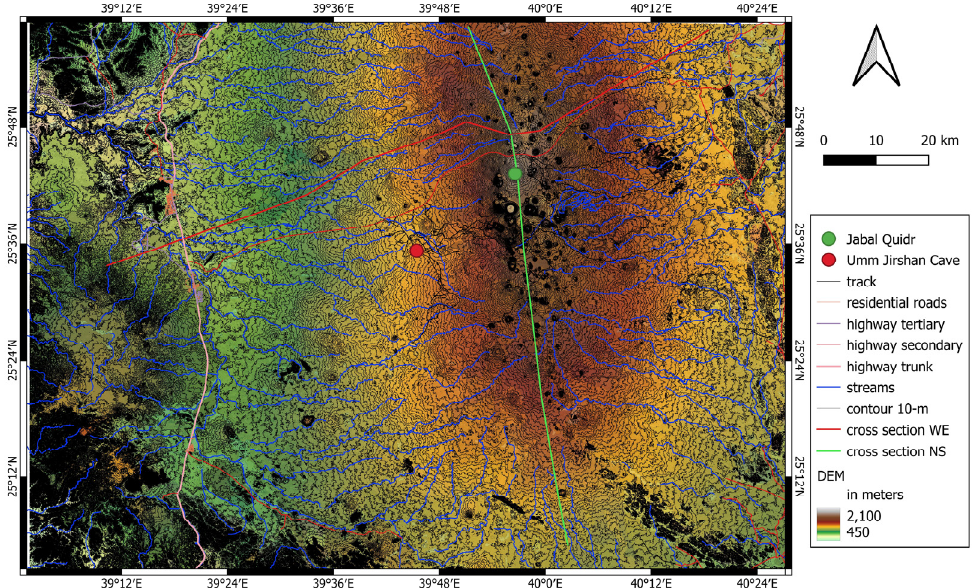
Figure 2. Digital terrain model based on the ALOS-PALSAR 12.5 m resolution elevation data over the geological map of the region. Young lava flows are clearly visible in the underlying map. Note the gentle sloping terrain and the dorsal-ridge-like feature upon which the volcanoes sit. Cross-section lines are marked on the map, and cross-sections are shown in Figure 3.